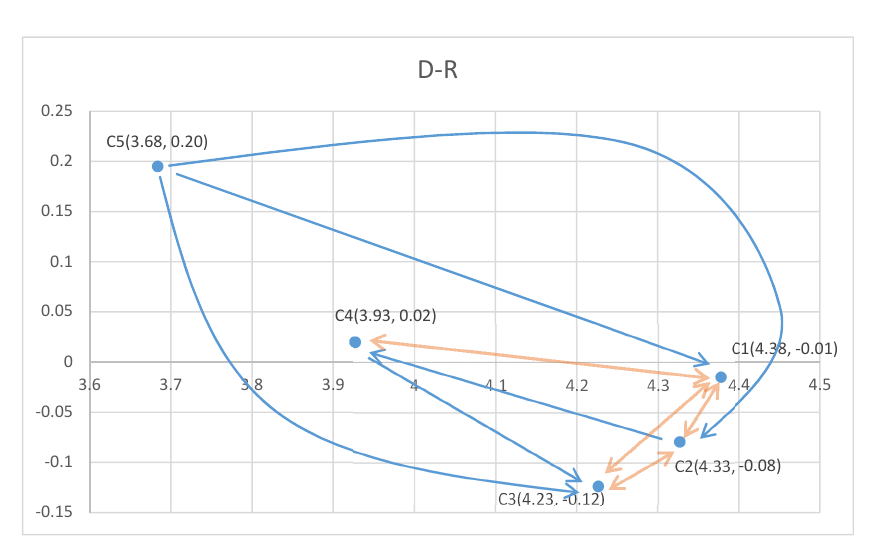
Table 5. DEMATEL results for the social aspect.